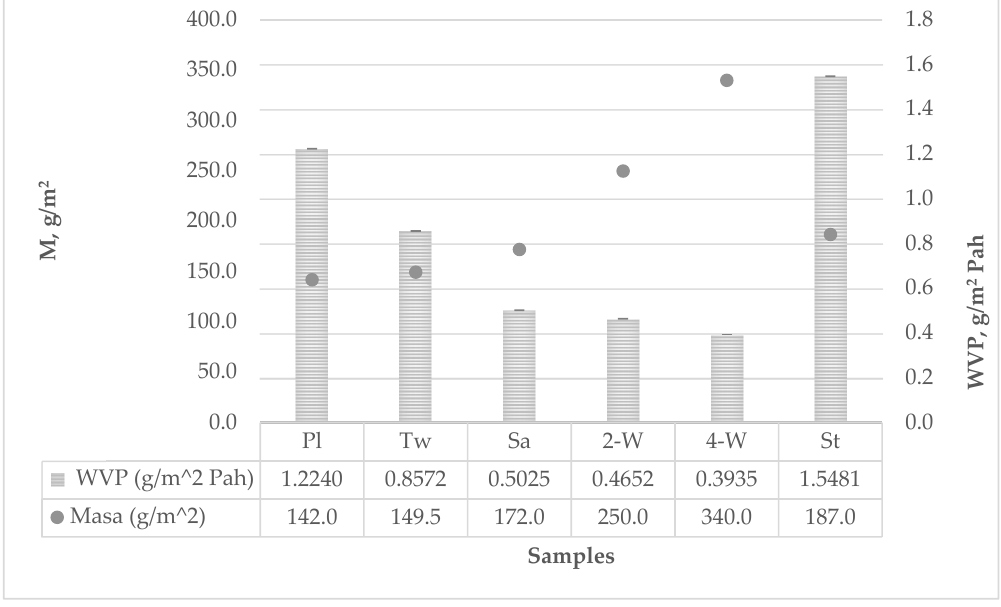
Figure 1. Water vapor permeability diagram.